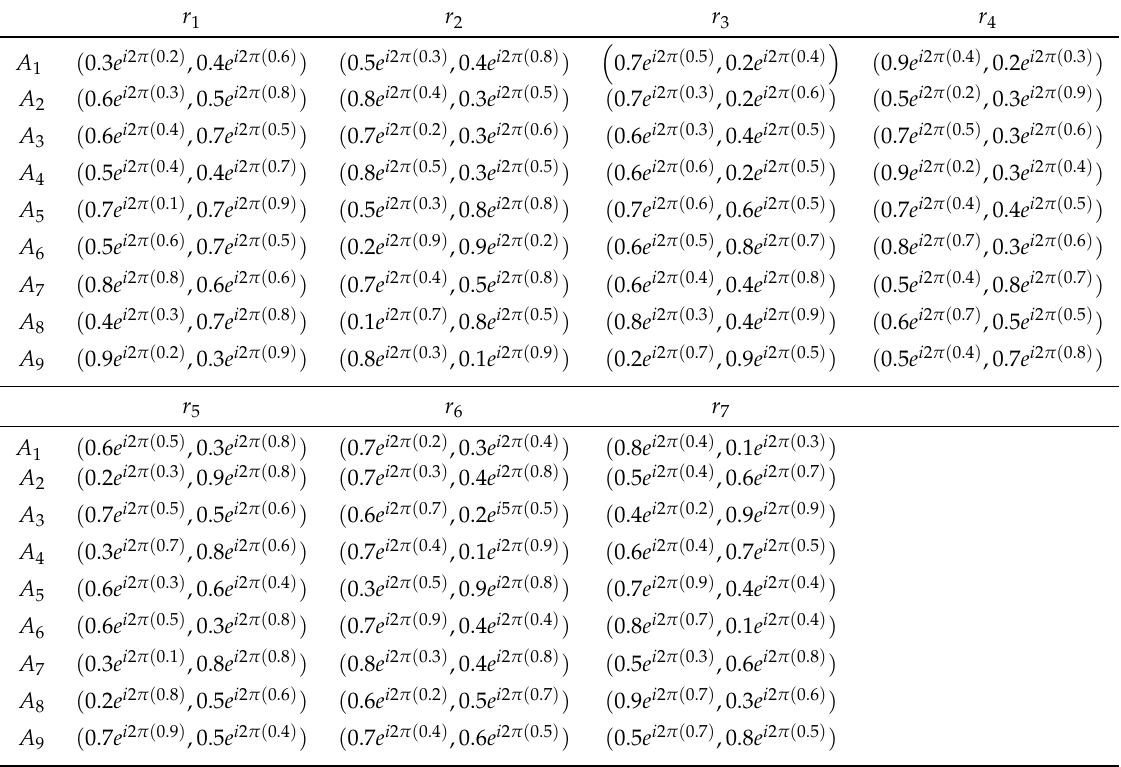
Table 1. The evaluation information on the projects in a complex Pythagorean fuzzy environment. r 1 r 2 r 3 r 4 A